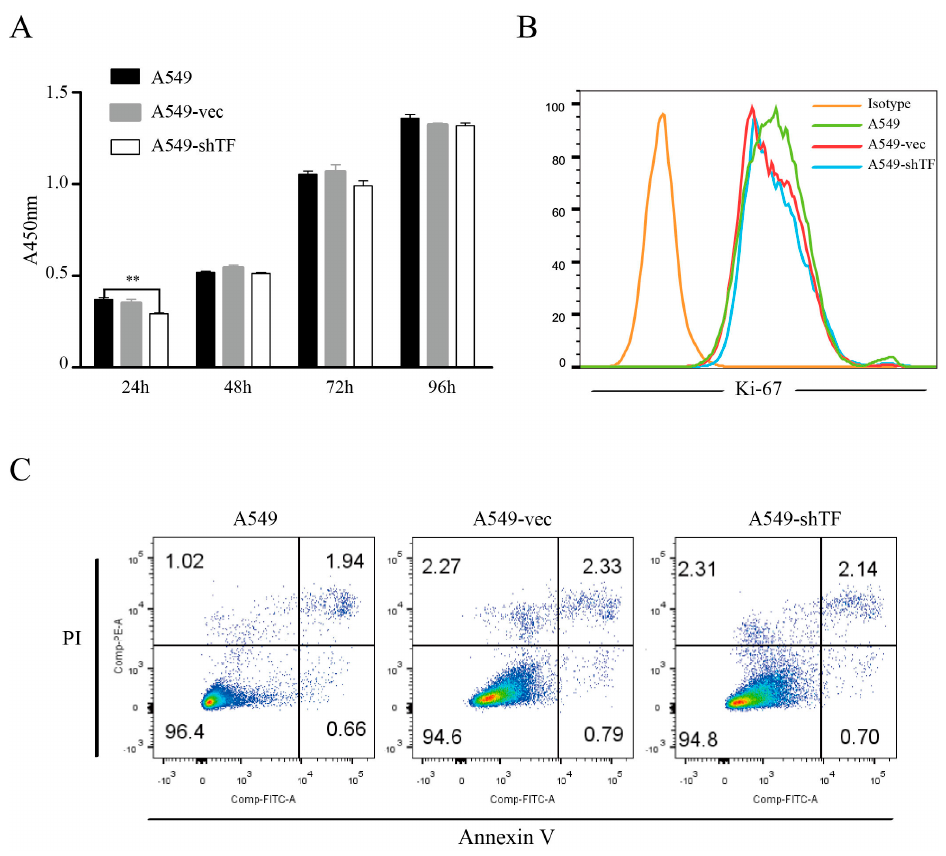
Figure 2. Evaluation of tumor cells proliferation and apoptosis after TF knockdown. ( A ) The proliferation of A549 cells, A549-vec cells, and A549-shTF cells was determined by cell counting kit-8 (CCK-8) assay ( n = 3); ( B ) the percentage of Ki-67 positive cell in A549 cells, A549-vec cells, and A549-shTF cells were measured by flow cytometry ( n = 3); ( C ) A549 cells, A549-vec cells, and A549-shTF cells apoptosis were detected by flow cytometry with Annexin V-FITC/PI staining ( n = 3). PI, Propidium Iodide, ** p < 0.01.